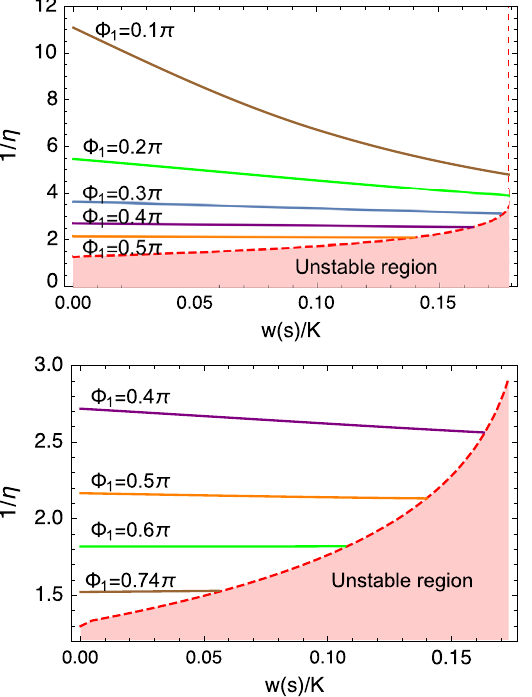
¼ 0 . 52 π , 1 FIG. 5. Coefficient 1 / η calculated using condition (34) and formula (31) for different values of phase advance Φ 1 of the first particle (35) as a function of normalized wakefield; lower panel: zoom of coefficient 1 / η to higher phase